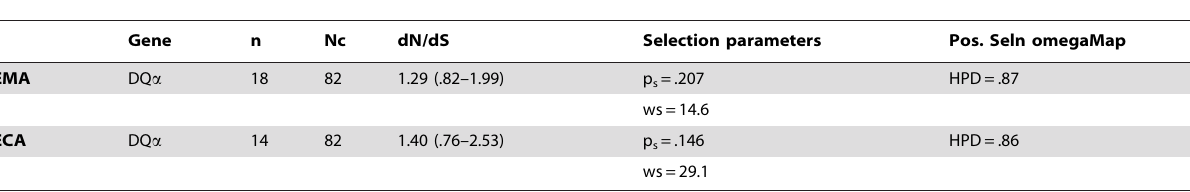
Table 1. Estimates of diversifying selection on exon 2 of the MHC DQ a locus.